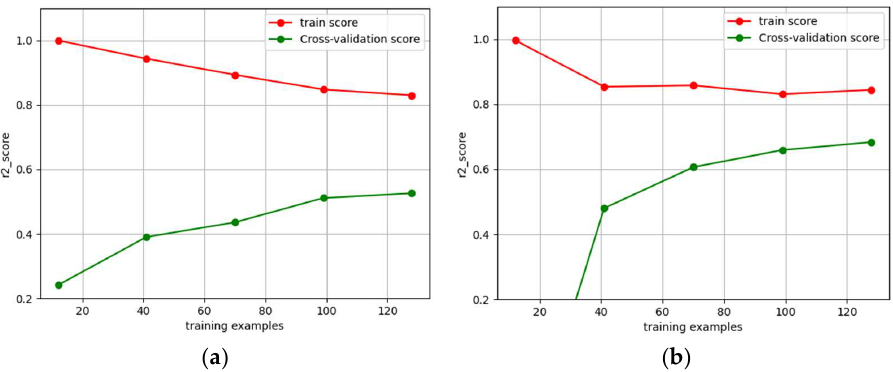
Figure 13. Learning curve of training samples: ( a ) Before dimension reduction; ( b ) After dimension reduction with CARS-LLE.